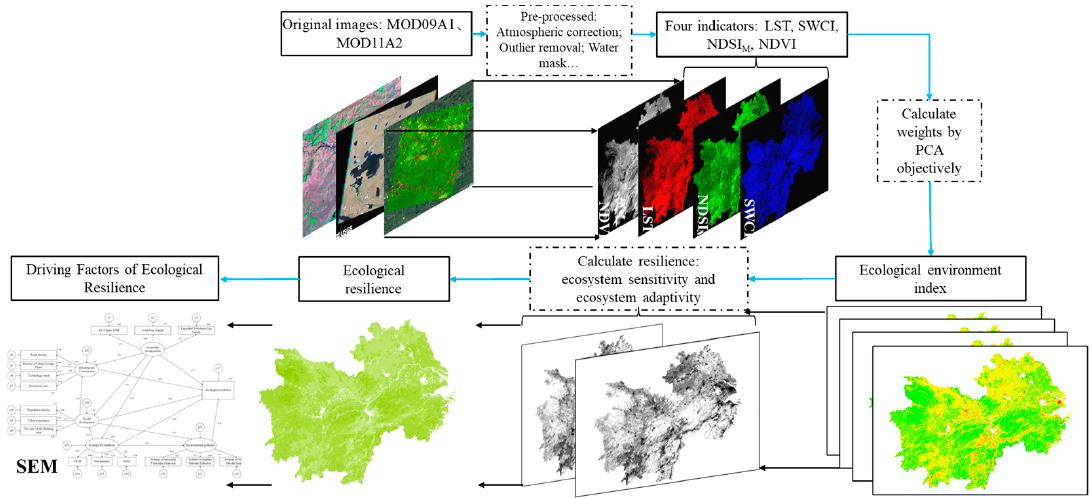
Figure 2. The methodology framework of RSEI and ecological resilience calculation.